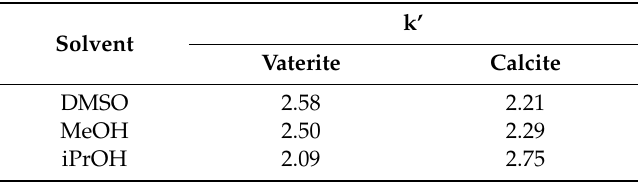
Table 4. The values of calculated capacity factors ( k’ ) for the tested normal phase high-performance liquid chromatography (NP-HPLC)